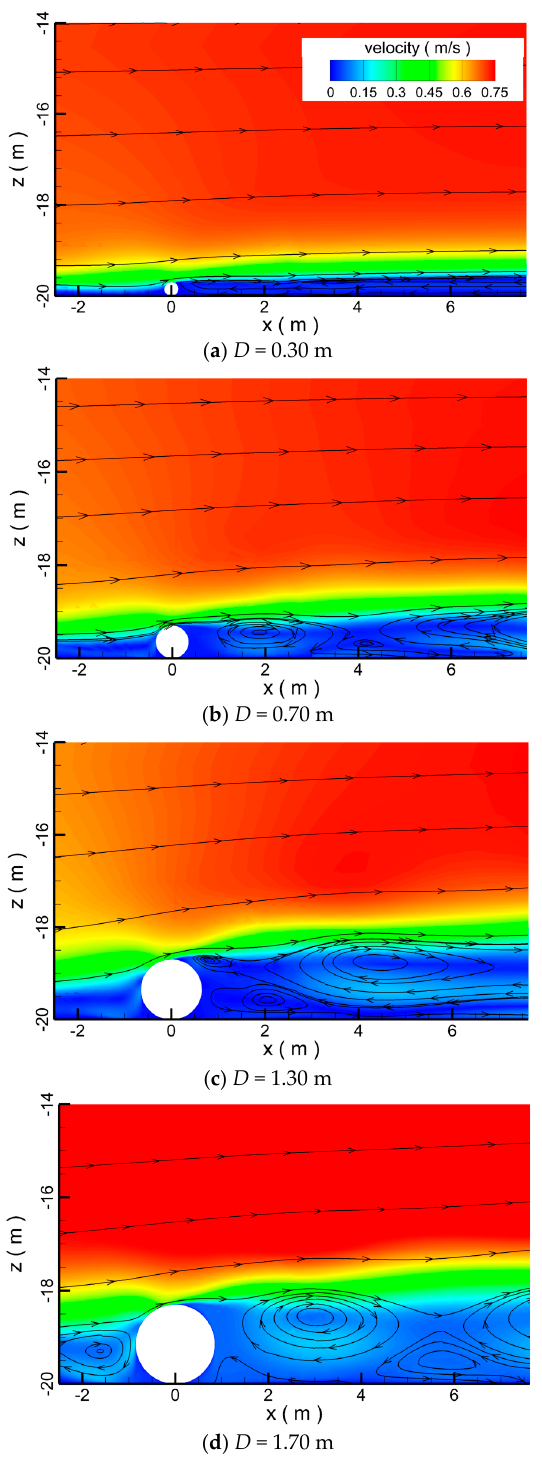
Figure 12. The flow fields around different diameter pipelines in time of t = 39 h.